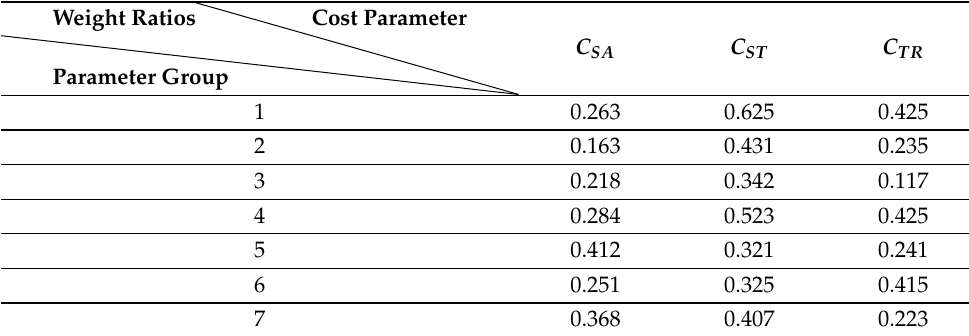
Figure 5. Convergence of objective function versus iterations. Table 2. Weight ratios of different cost.